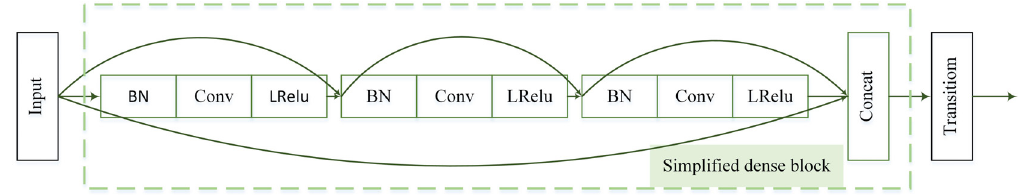
Figure 6. The network structure of simplified dense block.